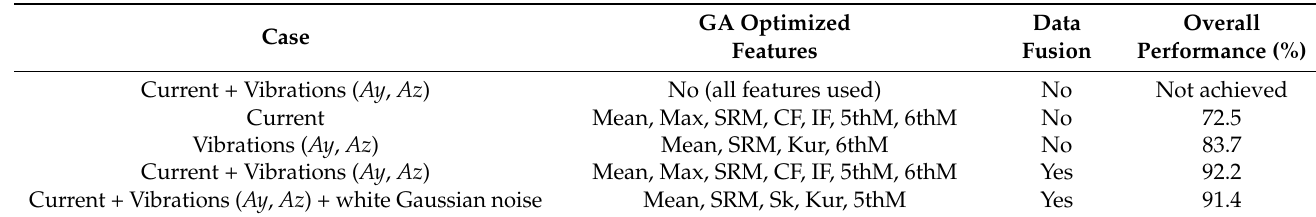
Table 1. Case studies performance